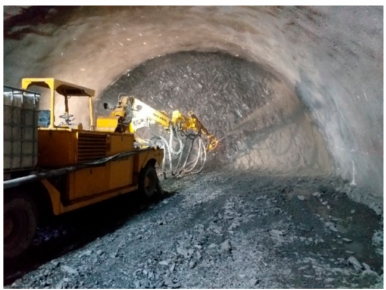
Figure 12. Detail of gunning operation in Arnotegi